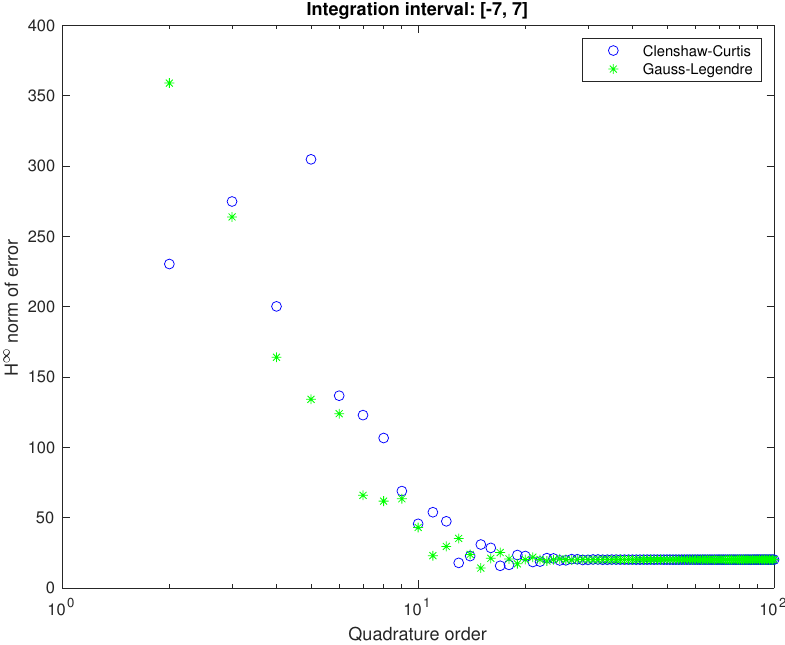
Figure 9. Analysis of (cid:107) e (cid:107) ∞ norm with increasing order of quadrature for the integration interval of [ − 7,7 ]